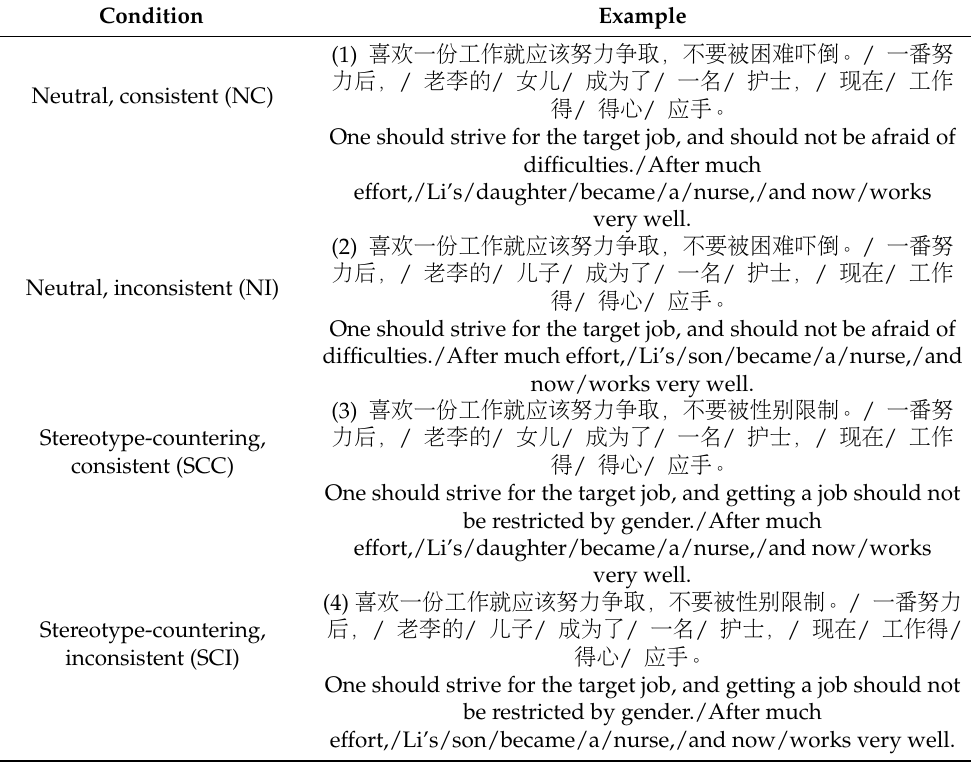
Table 1. Design and discourse examples for all four critical conditions. Examples are given in Chinese, with English glosses and translations. The critical words are in